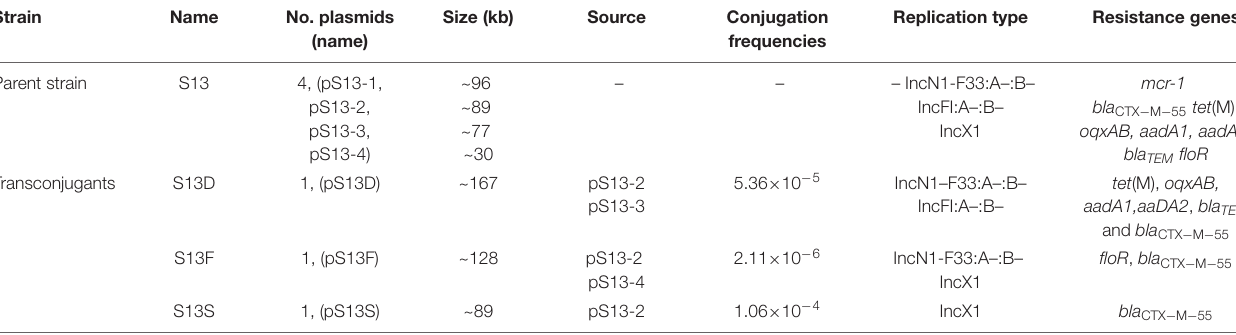
TABLE 1 | The characterizations of plasmid carried by strain S13 and its transconjugants. Strain